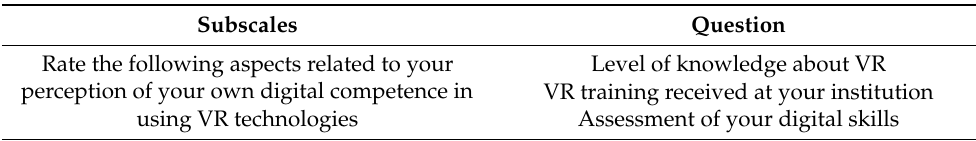
Table A1. Questions of the survey (all responses are given on a Likert scale from 1 to 5, where 1 means the lowest rating and 5 means the highest rating, in each